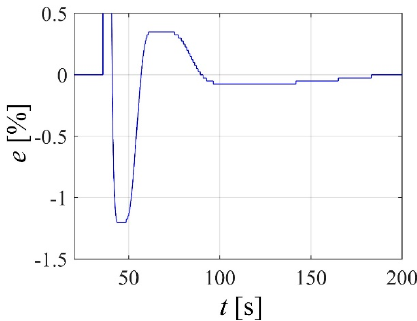
Figure 15. Closed-loop step results.